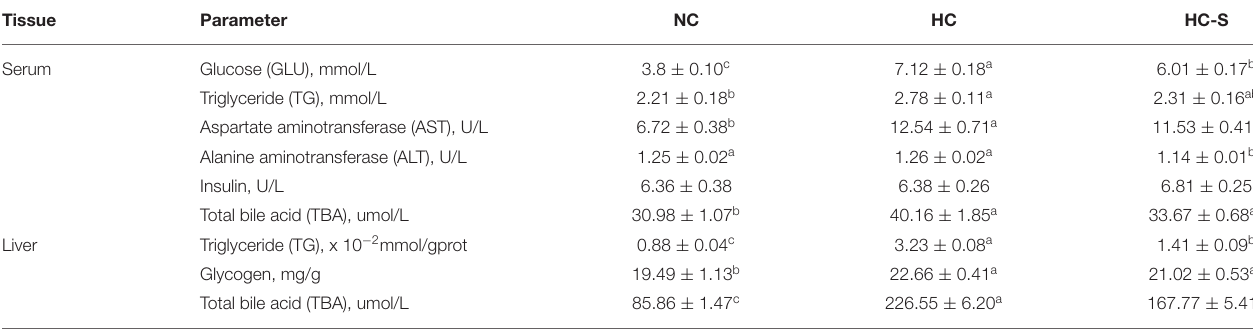
TABLE 4 | Effects of dietary SJ on hepatic and serum biochemistry of swamp eel fed HC diet.